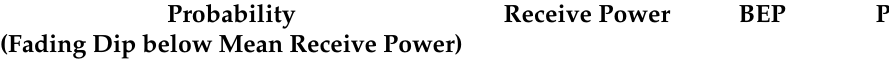
Table 2. Stepwise approximation of BEP and PEP for IOLW reliability estimation, based on ([25] Annex K). Probability Receive Power BEP